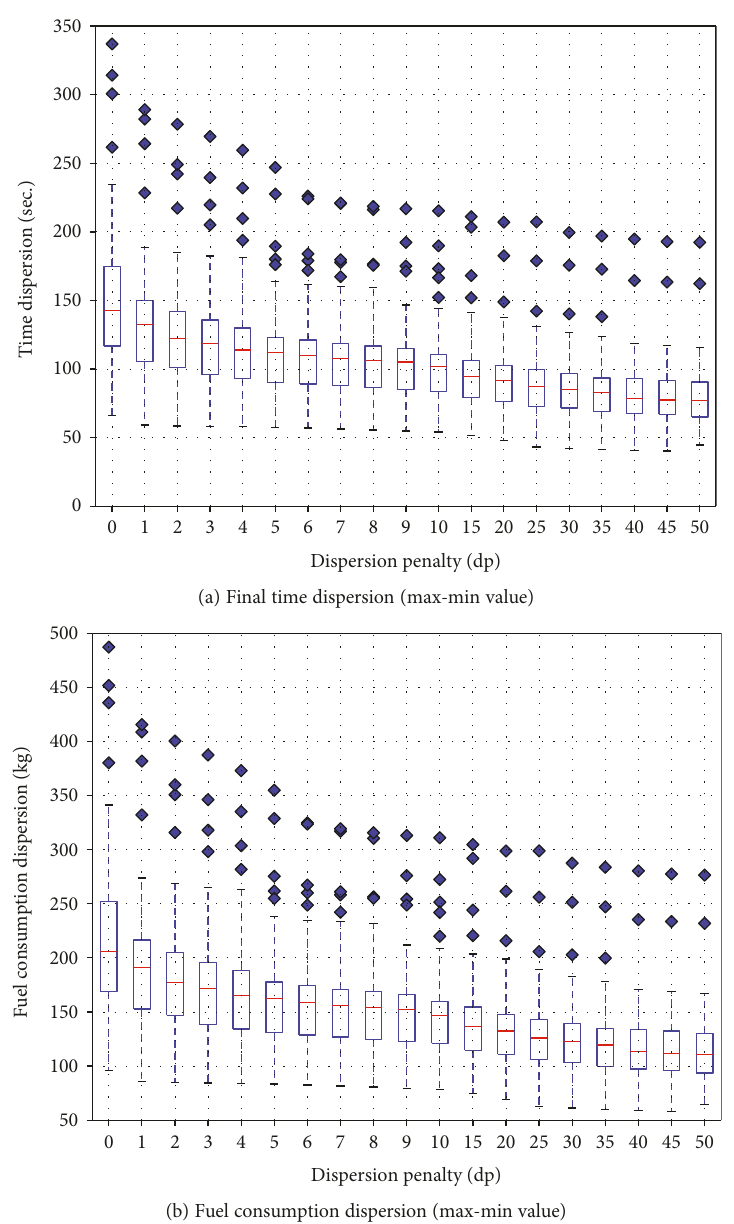
Figure 9: Aggregated dispersion boxplots for the single origin-destination case